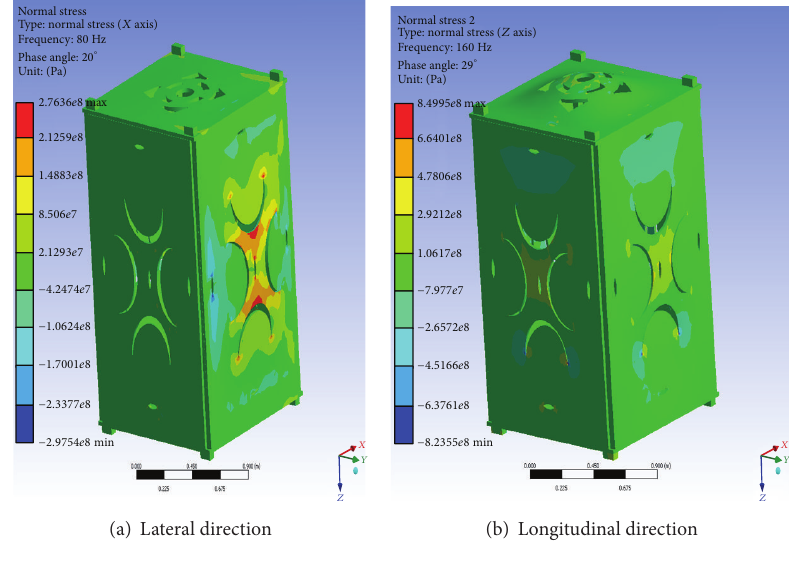
Figure 5: Stress